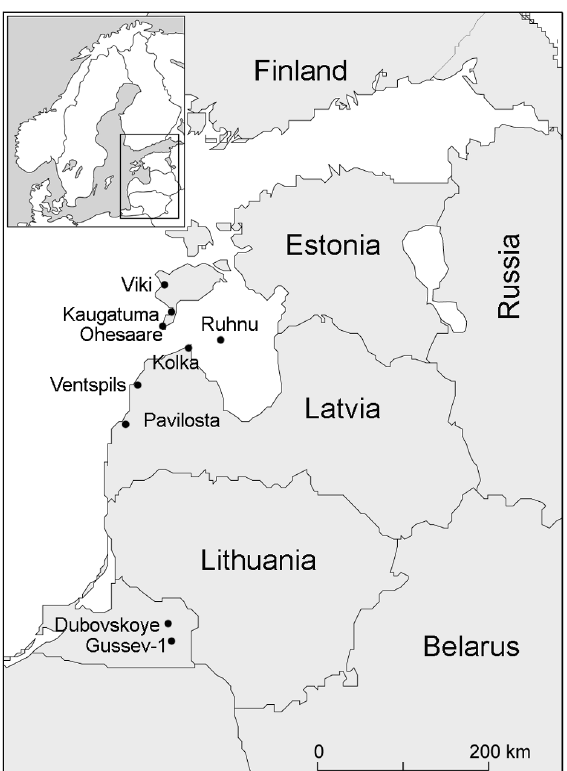
Fig. 1. Location of the studied drill